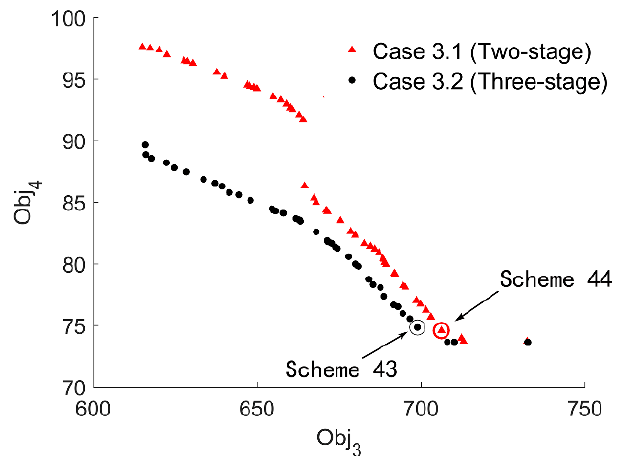
Figure 17. Pareto fronts obtained by di ff erent guide vane closing schemes in Case 3. Table 5. Partial Pareto optimal solutions by di ff erent closing